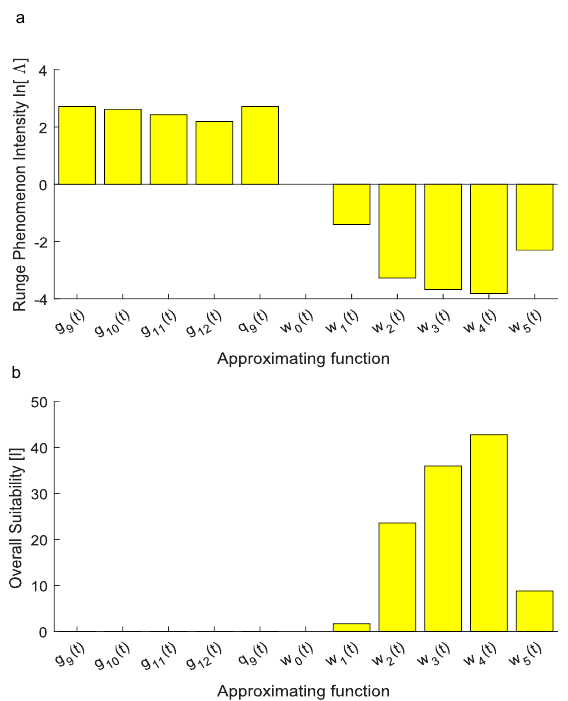
Figure 5. ( a ) The natural logarithm of the Λ f index was used to account for the intensity of the Runge phenomenon since it is able to graphically show whether approximating functions were affected by the Runge phenomenon. The first approximation obtained through the Vandermonde ) . Similarly, for g ( t ) , · · · , g ( t ) , this logarithm was approach resulted in a positive value of ln ( Λ g 9 12 9 ( t ) positive since the Runge phenomenon affected predictions. On the contrary, for w 1 ( t ) , · · · , w 5 ( t ) , this logarithm resulted in negative values and the Runge phenomenon did not affect numerical ) increased without predictions of inter-interval values. For the function w 0 ( t ) , the index ln ( Λ w 0 ( t ) bound towards − ∞ (not shown within the plot). ( b ) Overall suitability: Considering both the ability of each candidate function to reproduce experimental values and the intensity of the Runge phenomenon affecting numerical predictions, the overall suitability shows that only the w n ( t ) family was able to reproduce experiments in a suitable way. Among the w n ( t ) functions, the w 4 ( t ) was also the most suitable to reproduce experimental data for inter-interval